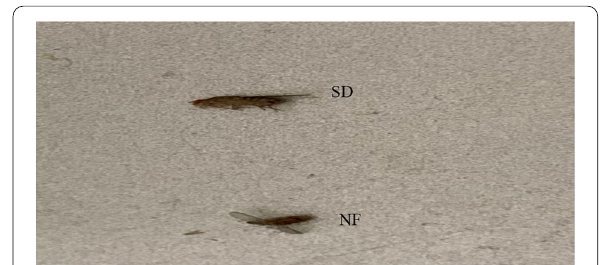
Fig. 3 Haemolymph glucose level after treatment with probiotic. Error bars having different superscript letters a,b Indicate statistically significant p < (0.05) different